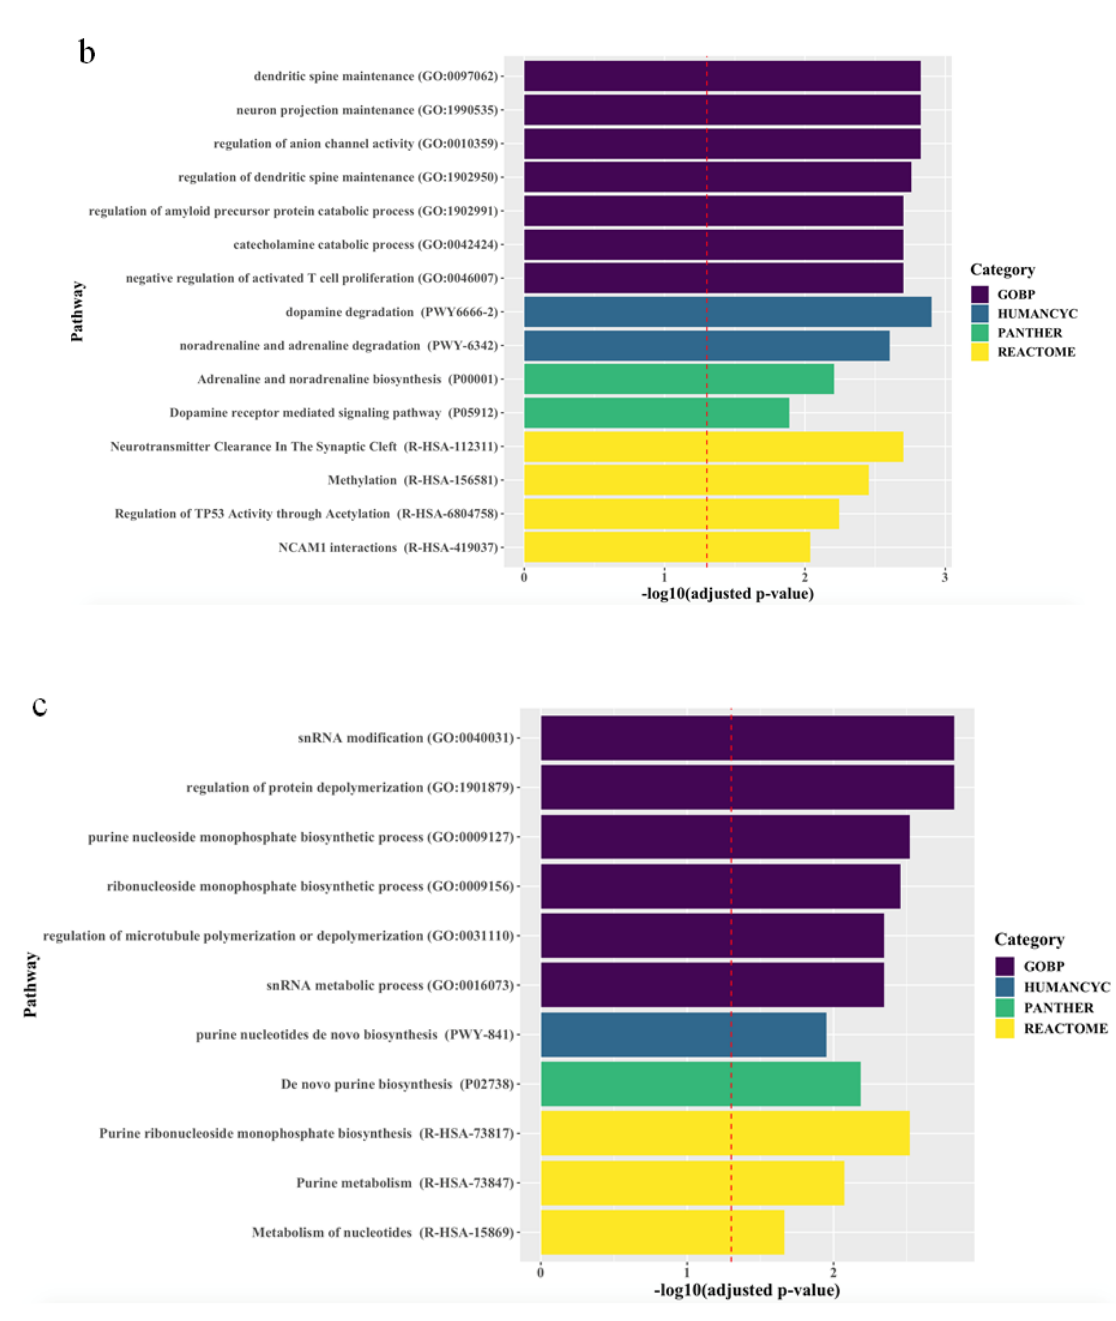
Figure 1. Top ranking candidate genes according to Gene Ontology with Biological Pathway (GO-BP), HumanCyc, Panther, and Reactome analyses. After adjustment using the Benjamini–Hochberg method, an adjusted p < 0.05 was taken to denote statistical significance. The results are ordered by significance in all categories. The red dashed vertical line represents adjusted p = 0.05, and ( a ), ( b ), and ( c ) indicate results in the total population, men, and women, respectively.